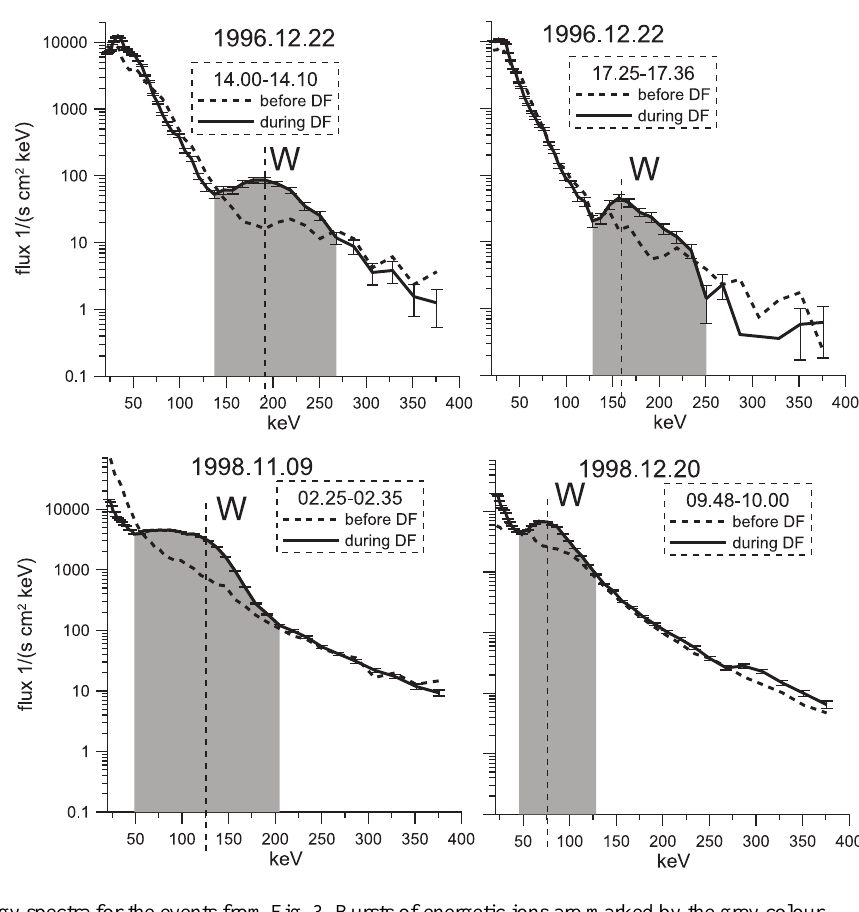
Fig. 4. Ion high-energy spectra for the events from Fig. 3. Bursts of energetic ions are marked by the grey colour.